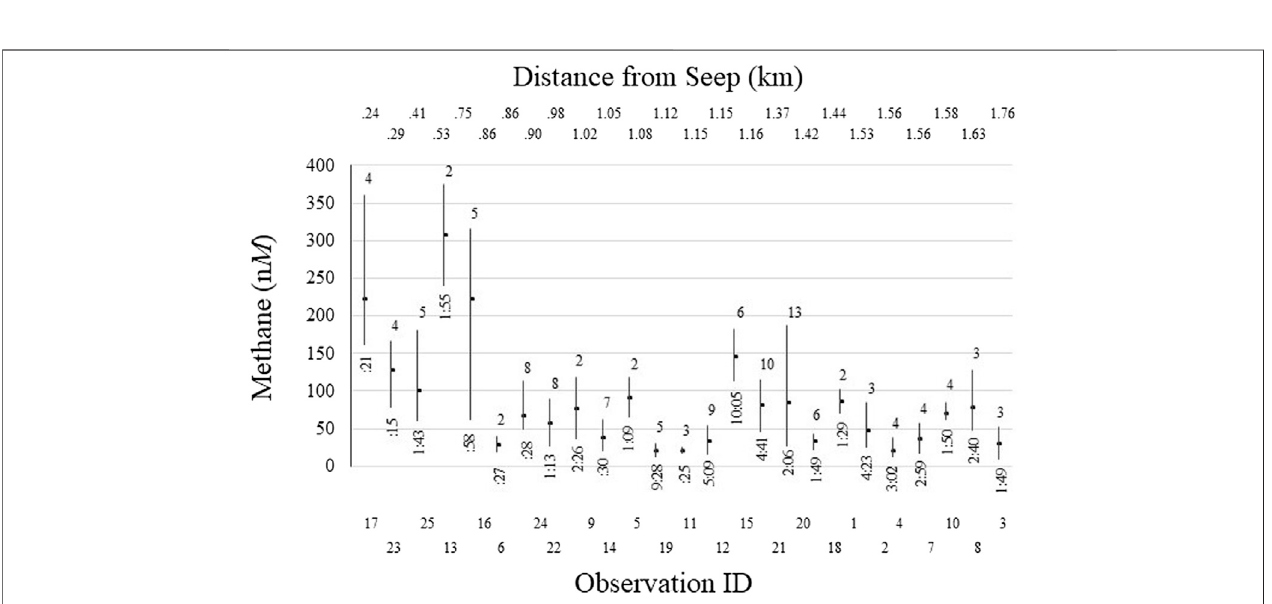
FIGURE 9 | The plot shows the temporal variation at 25 points of varying distance from the source during the spring study. The horizontal distance is not scaled in the fi gure see the upper axis label. Observations numbers are shown on the lower axis. The number of replicate observations is shown above the observed range. The duration of observations is shown below. The vertical lines represent the spread of the observed concentrations with the tick mark indicating the average for each set of measurements.